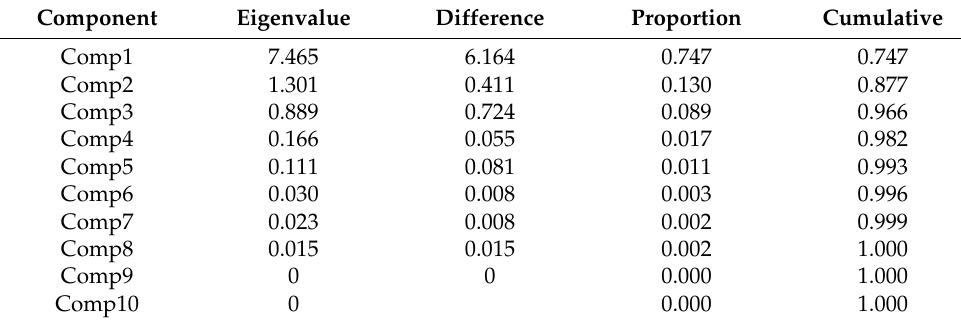
Table A3. PCA estimation for food security.